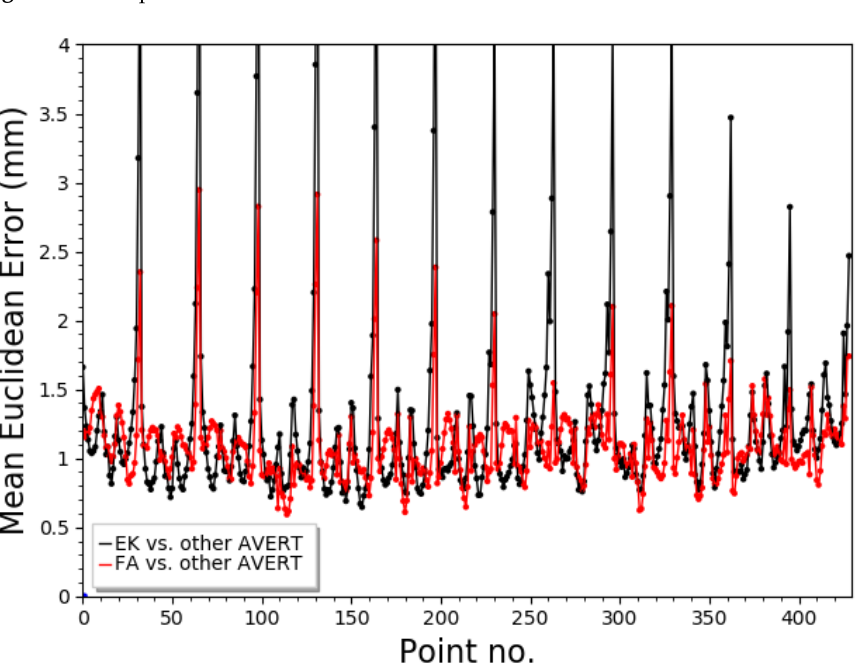
Table 2. Comparison between F.A. and the other observers (E.K., I.H., and M.M.) using Mann – Whitney U-test.